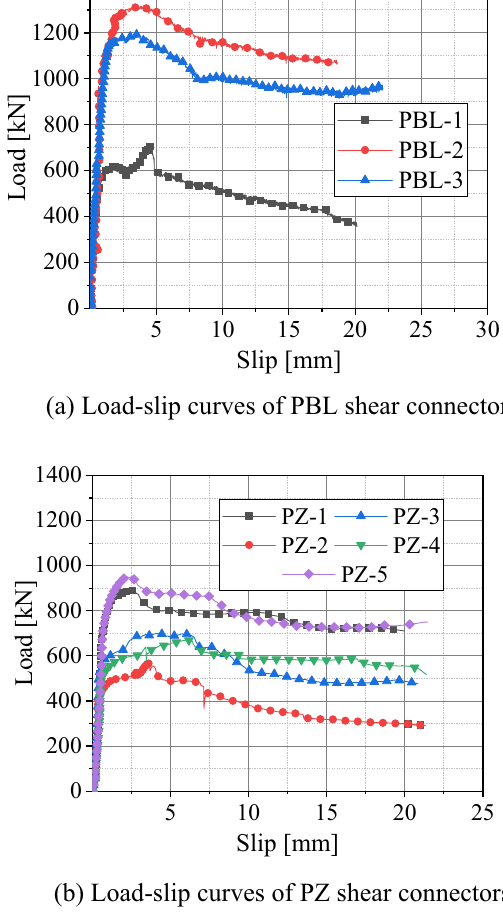
Figure 10. Load–slip curves of specimens.